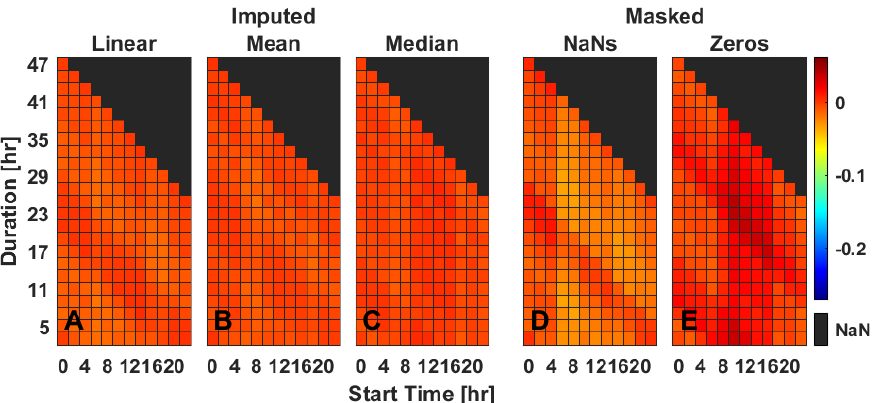
Figure 4. Rhythm fragmentation (IV) for two gaps (gap 1:115 min, gap 2:140 min) of missing data starting on a representative day (Tuesday). Data are the mean difference between the masked and true IV values ( D , E ) or imputed and true IV values ( A – C ), as extracted from Bland–Altman plots. Three different imputation methods [linear interpolation ( A ), mean ToD ( B ), median ToD ( C )] and two masking methods [NaNs ( D ), zeros ( E )] are presented for varied durations between bouts ( y -axis) and timing ( x -axis) of masked data gaps. Values are color-coded as indicated with best performance being closer to 0; NaN values indicate where values could not be calculated due to dataset